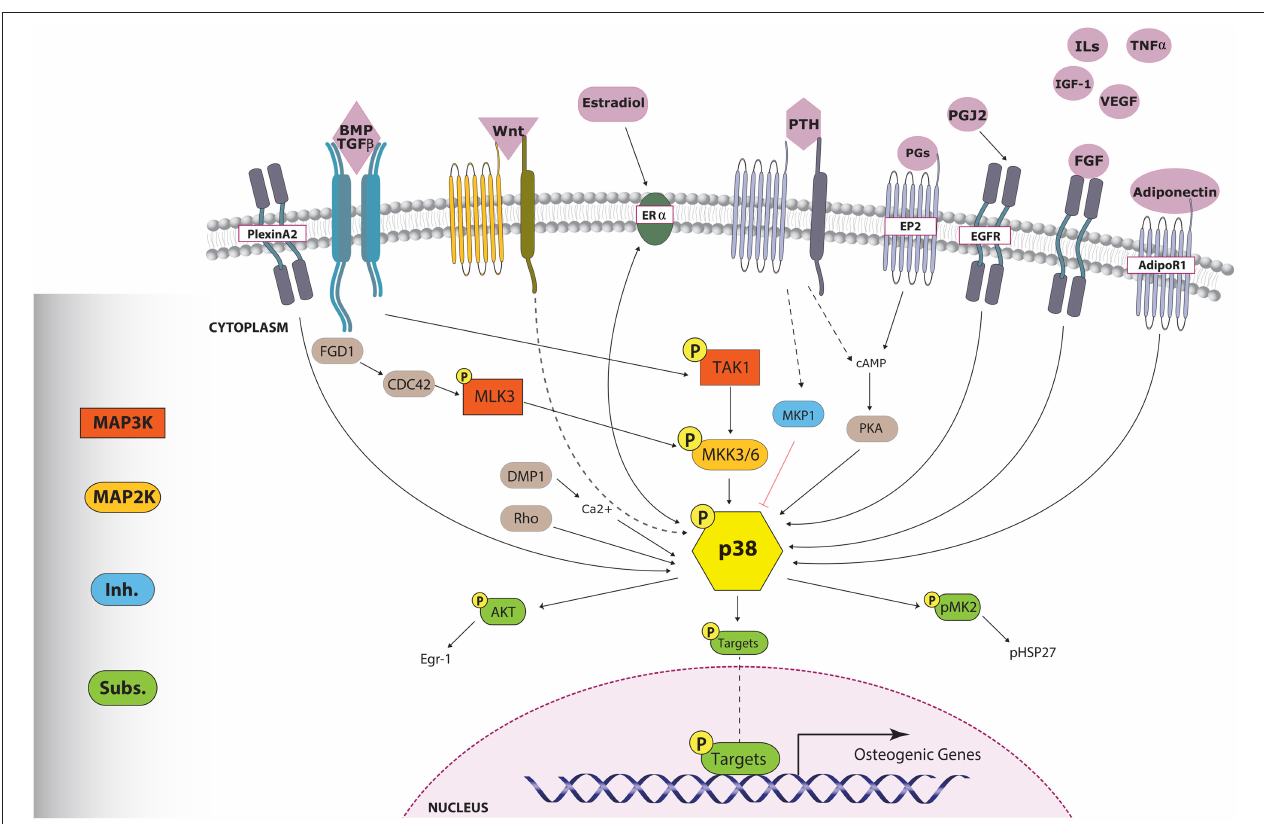
FIGURE 2 | p38 triggers involved in osteogenesis. Numerous stimuli, through distinct mechanisms, lead to p38 MAPK phosphorylation. Activated p38 phosphorylates important osteoblast-related transcription factors, which will enhance osteogenic gene expression. pp38 can also trigger other pathways through the activation of cytoplasmic-acting substrates such as AKT and pMK2. Sharp arrows indicate direct activation. Dashed arrows indicate an unknown or indirect mechanism of action while the red flat-tipped arrow denotes